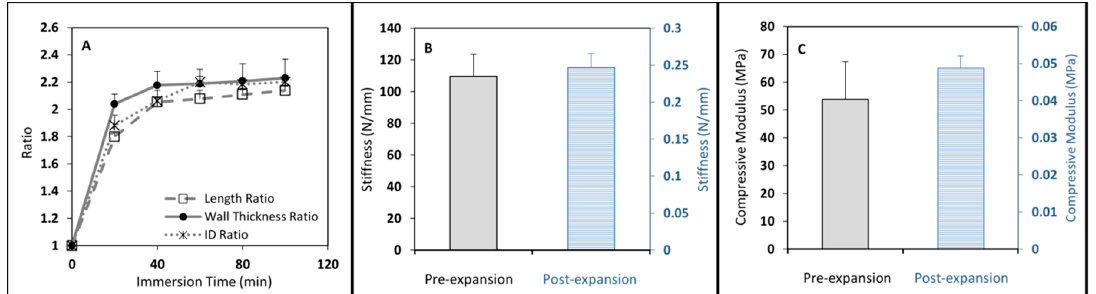
Figure 3. ( A – C ): Unexpanded (dry) and expanded 12 mm cages were compressed to obtain compressive mechanical properties. As expected, dry cages presented much higher compressive